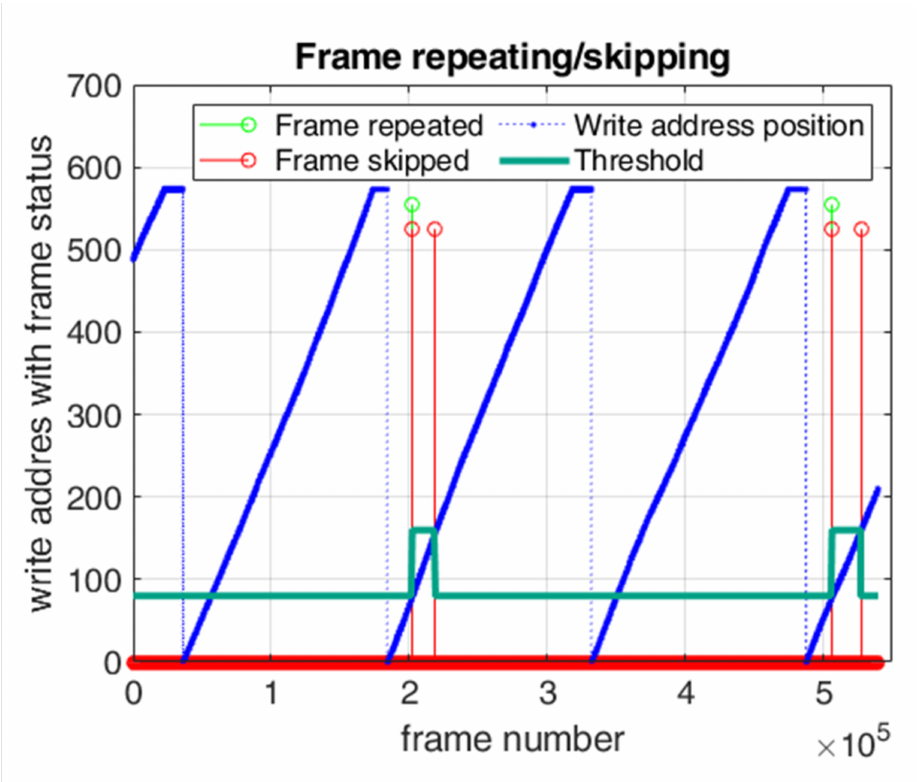
Figure 8. Modified triple buffering: hysteresis change. Table 1. Buffering techniques.